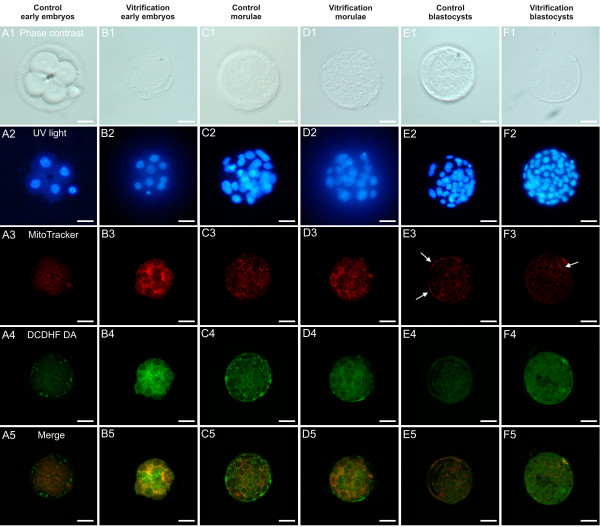
Photomicrographs of fresh and vitrified/warmed mouse embryos at early (4/16-cell), morula and blastocyst stages of development as assessed for their nuclear chromatin and bioenergy/oxidative potential. For each embryo, corresponding bright-field (phase contrast; lane 1), UV light (lane 2) and confocal images showing mt distribution pattern (lane 3), ROS localization (lane 4) and mt/ROS merge (lane 5), are shown. Representative photomicrographs of control non-vitrified and vitrified/warmed embryos at the 4- (row A) and 8-cell (row B), morula (rows C and D) and blastocyst stages (rows E and F), are shown. Nuclear chromatin was stained with Hoechst 33258.MitoTracker Orange CMTM Rosand DCDH FDA were used to label mitochondria and ROS, respectively. In control fresh early embryos and in morulae, in all blastomeres, there were detectable MitoTracker signals in the form of continuous rings around the nuclei and clusters of mitochondria at the cortex, namely perinuclear/pericorticalmt pattern (heterogeneous, healthy P/P mt pattern) (A3, C3). Vitrified early embryos(B3) showed a uniform/diffused (homogeneous) mt distribution pattern throughout the blastomere cytoplasm. In embryos at the morula and blastocyst stage, the mt pattern was apparently not affected by vitrification (D3 vs C3 and F3 vs E3). A higher number of red fluorescent spots is evident on the trophoectoderma (white arrows) compared with the inner cell mass, indicating differences in mt number/cell between these two embryo lineages and higher mt/number and aggregate formation in the trophoectoderma compared with ICM. This feature can be observed in embryos of both groups, thus it was not influenced by vitrification. ROS intracellular localization (lane 4) corresponded to the distribution pattern of mitochondria. In fresh control embryos, apart areas/sites of mt/ROS overlapping (merge, lane 5), intracellular ROS appeared diffused throughout the cytoplasm (A4, C4, E4). In vitrified (B4, D4 and F4) embryos, diffused MitoTracker and DCDH FDA labelling were evident throughout the cytoplasm. Scale bar represents 20 μm.